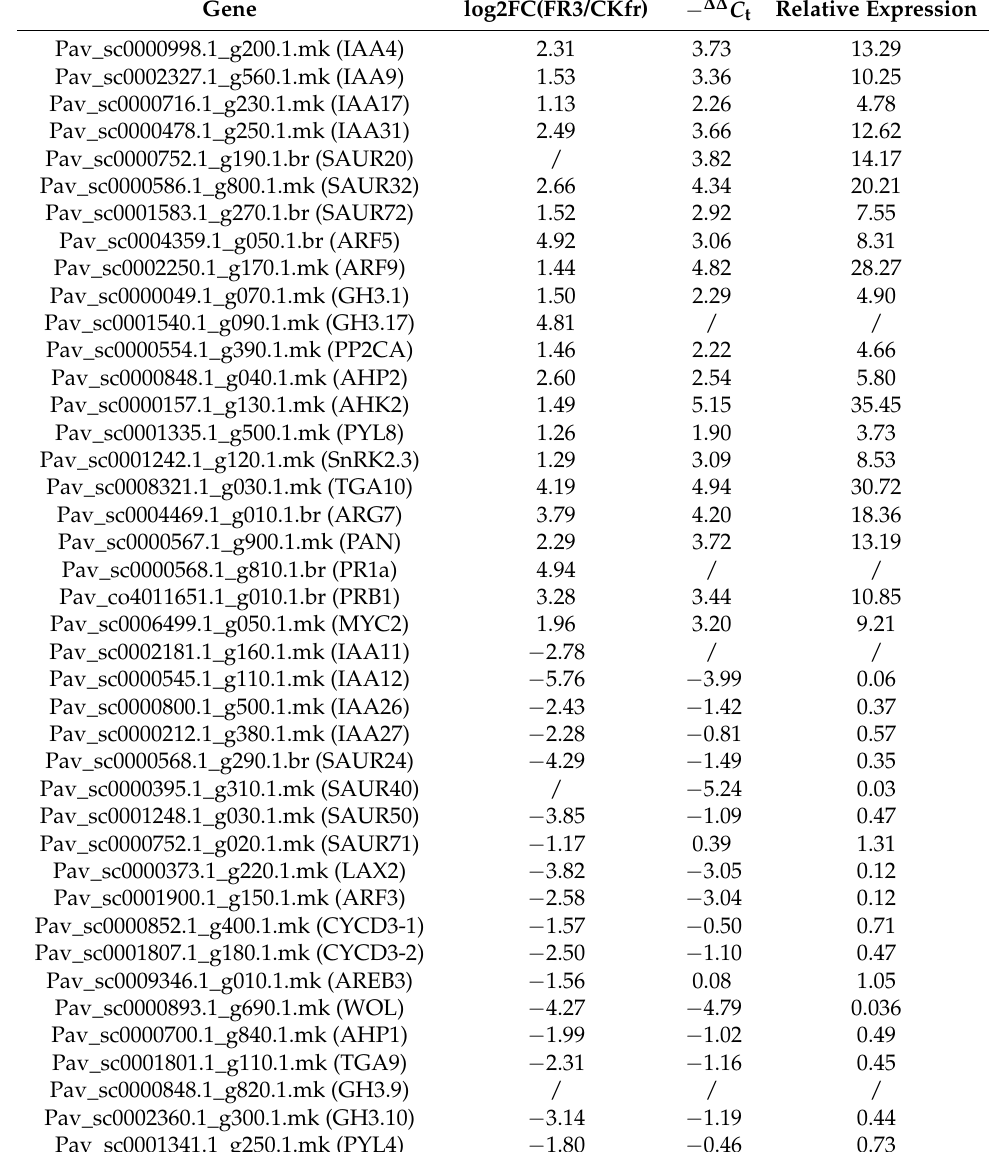
Table 1. Log2FC, − ∆∆ C t, and relative expression values of selected